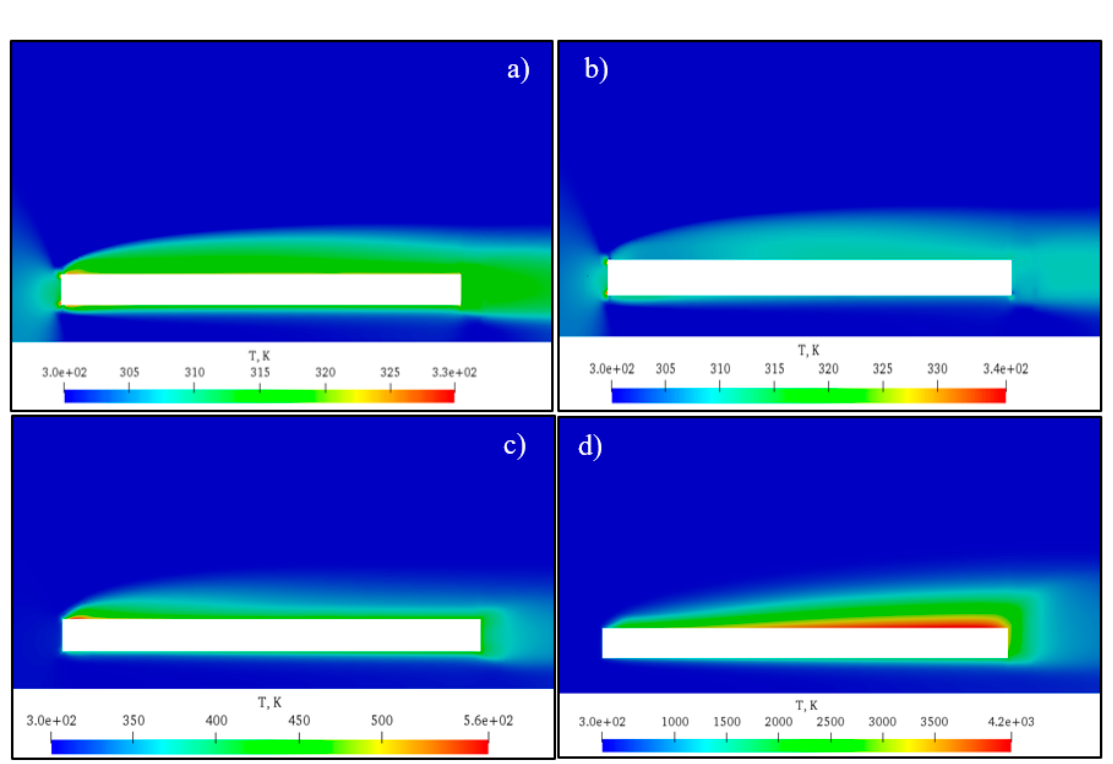
Figure 10. Temperature distribution around the batteries for pressure: ( a ) 100 kPa, ( b ) 10 kPa, ( c ) 1 kPa and ( d ) 100 Pa.